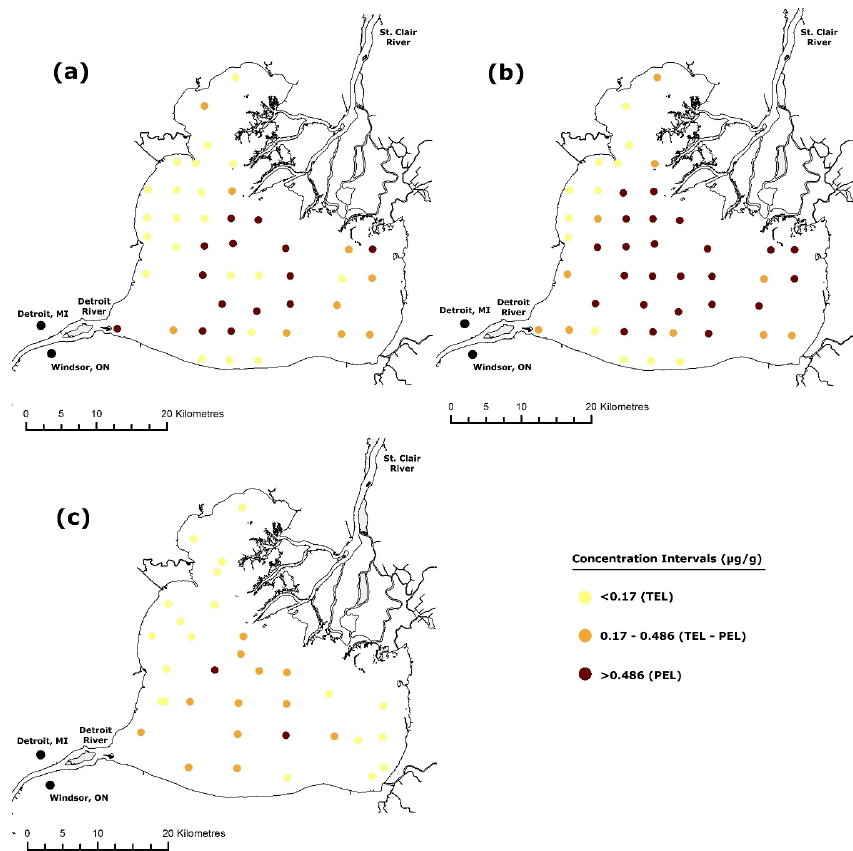
Figure 2. Two ‐ dimensional dot map sample distribution maps: ( a ) 1970; ( b ) 1974; ( c ) 2001. Figure 2. Two-dimensional dot map sample distribution maps: ( a ) 1970; ( b ) 1974; ( c )